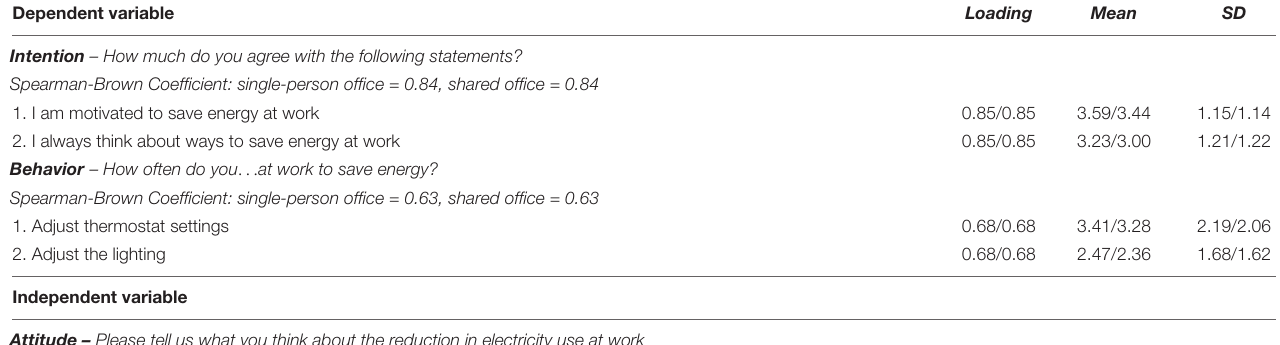
TABLE 1 | Factor loadings, means, and standard deviations of dependent and independent variables. Dependent variable